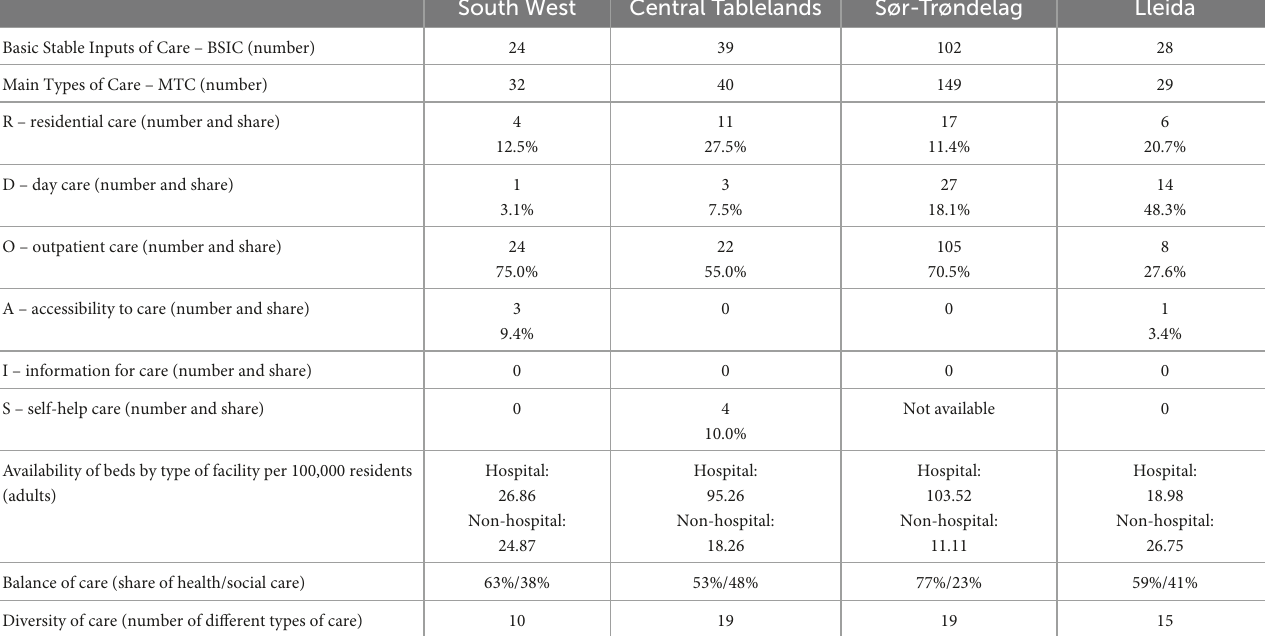
South West Central